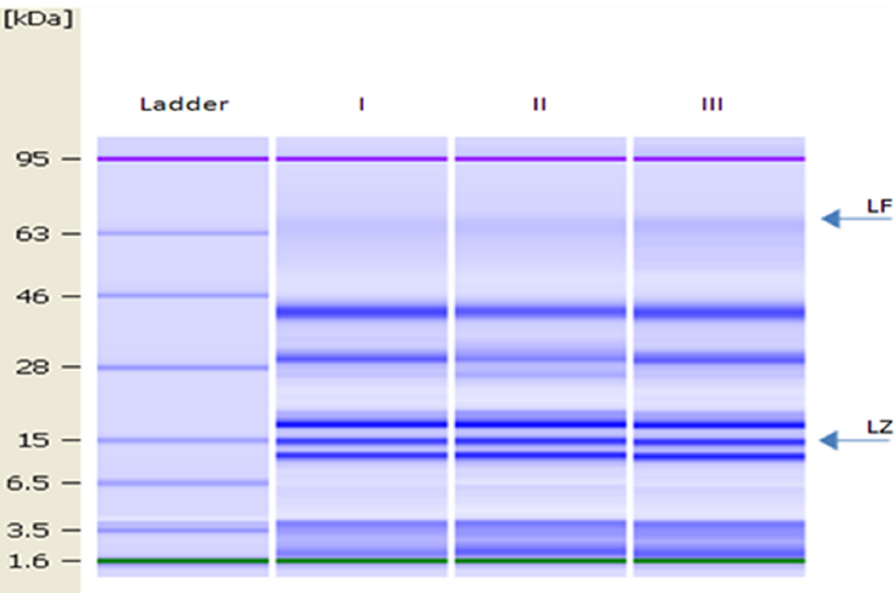
Figure 2. Lab-on-a-Chip gel images of lane 1, molecular mass ladder (1.6, 3.5, 6.5, 15, 28, 46, 63 and 95 kDa); lanes I–III, DM samples. Arrows indicate the position of LF and